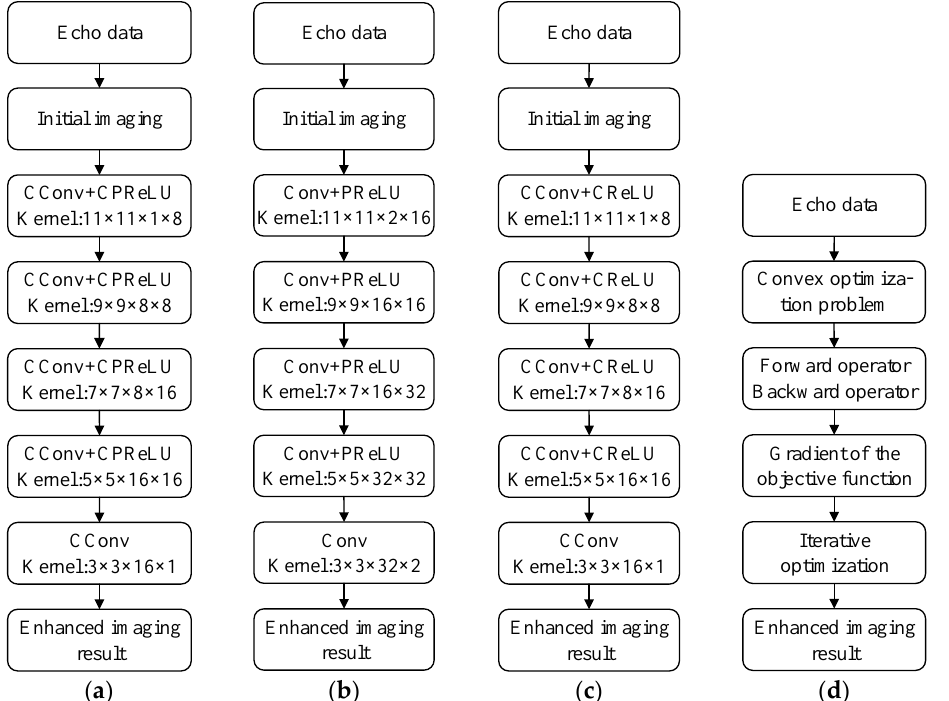
Figure 4. Structures of enhanced MMW 3-D imaging: ( a ) the proposed CVFCNN (CPReLU); ( b ) RVFCNN (PReLU); ( c ) CVFCNN (CReLU); ( d ) operator-based CS. Table 1. Parameters for generating simulated